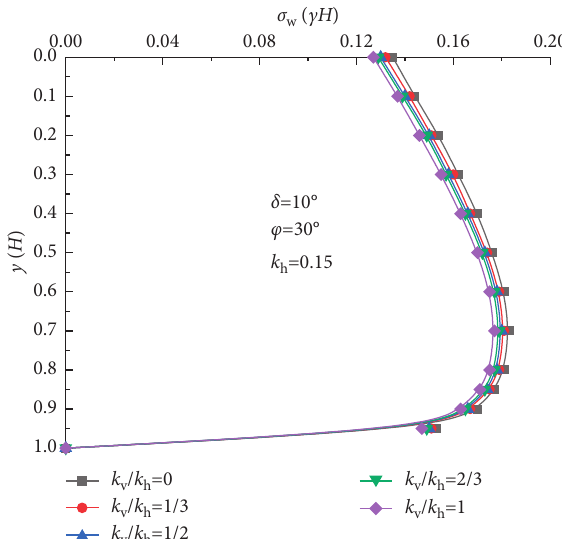
Figure 12: Influence of (k) v on seismic active earth pressure distribution.